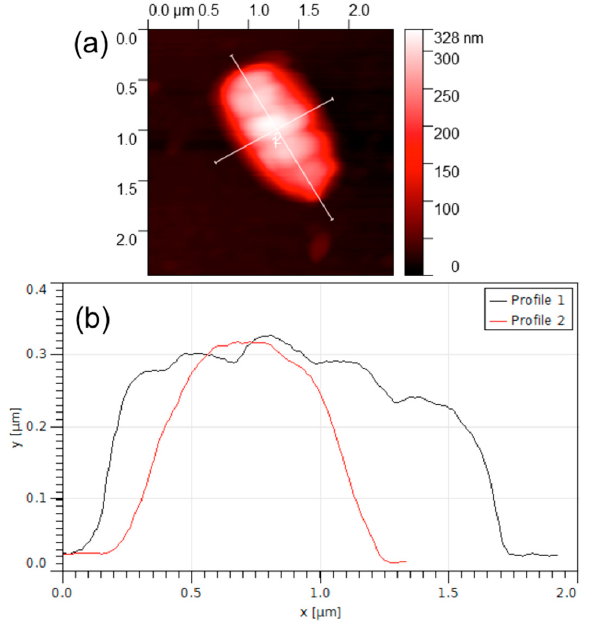
Figure 5. AFM image of an E. coli cell. ( a) AFM image ( b ) observational results.